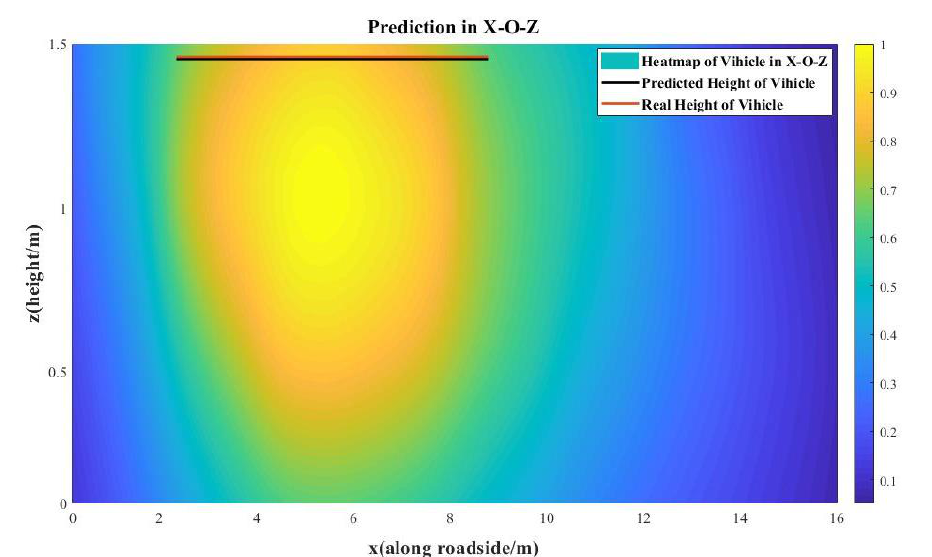
Figure 14. The heat map image of the vehicle at the location of (4 m, 2 m) in the X-O-Z plane. The height of the vehicle is predicted with a height contour threshold of 0.85.